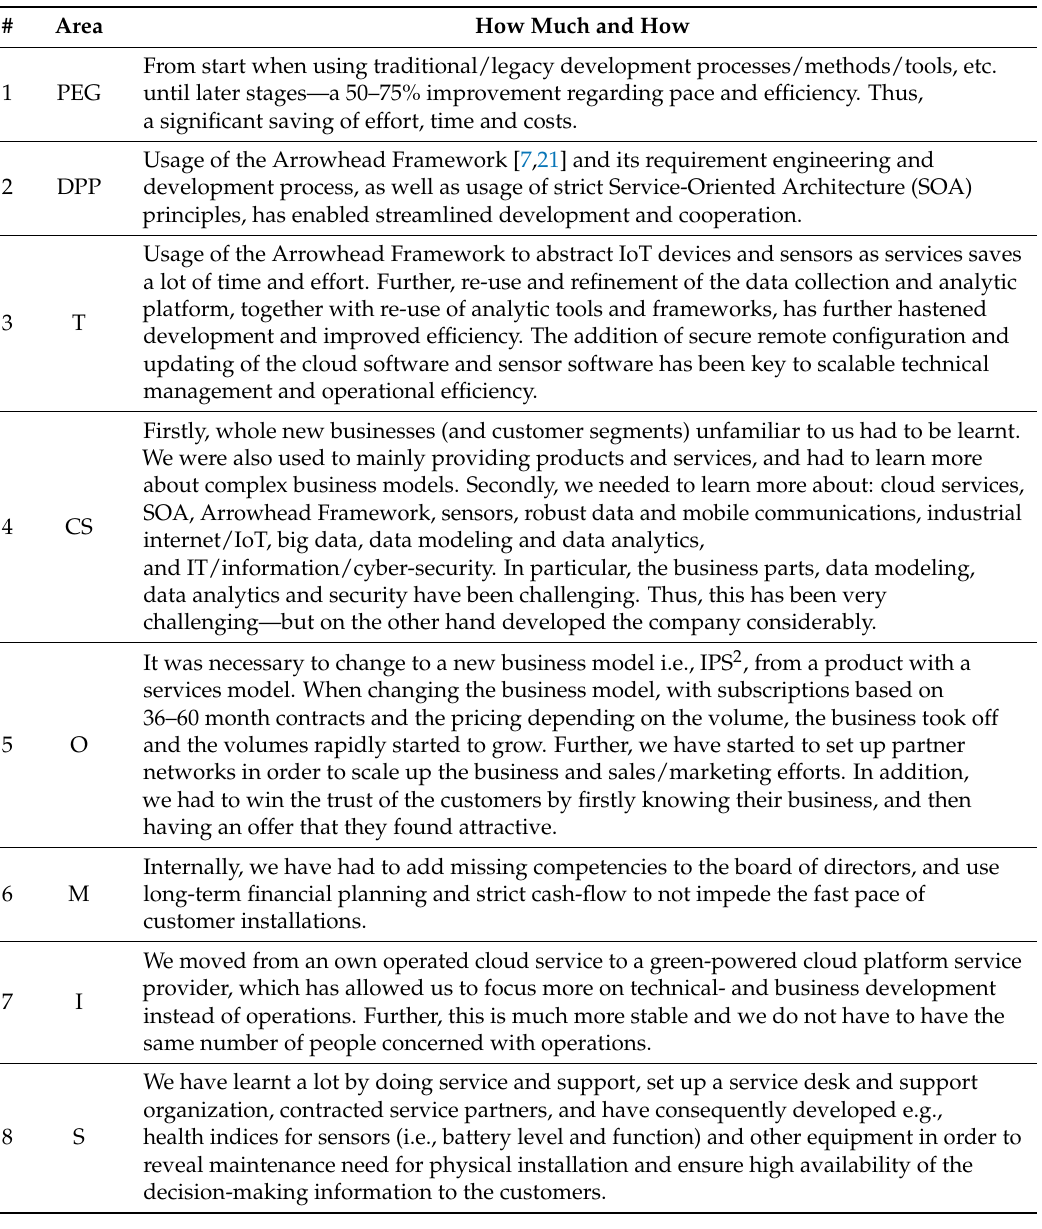
Table 1. Improvement and how a high development pace and efficiency has been accomplished at Adage